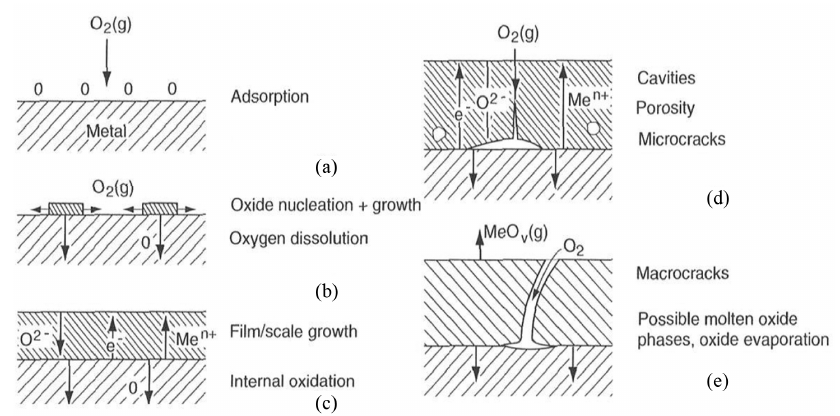
Figure 5: Sequence of oxide scale formation of a metal during high temperature oxidation.